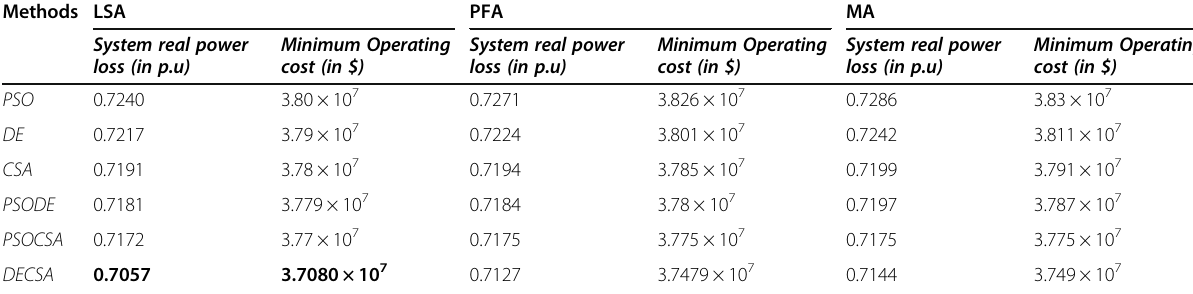
Table 8 Optimal performance for Indian 62-bus practical system of three different methods Methods LSA PFA